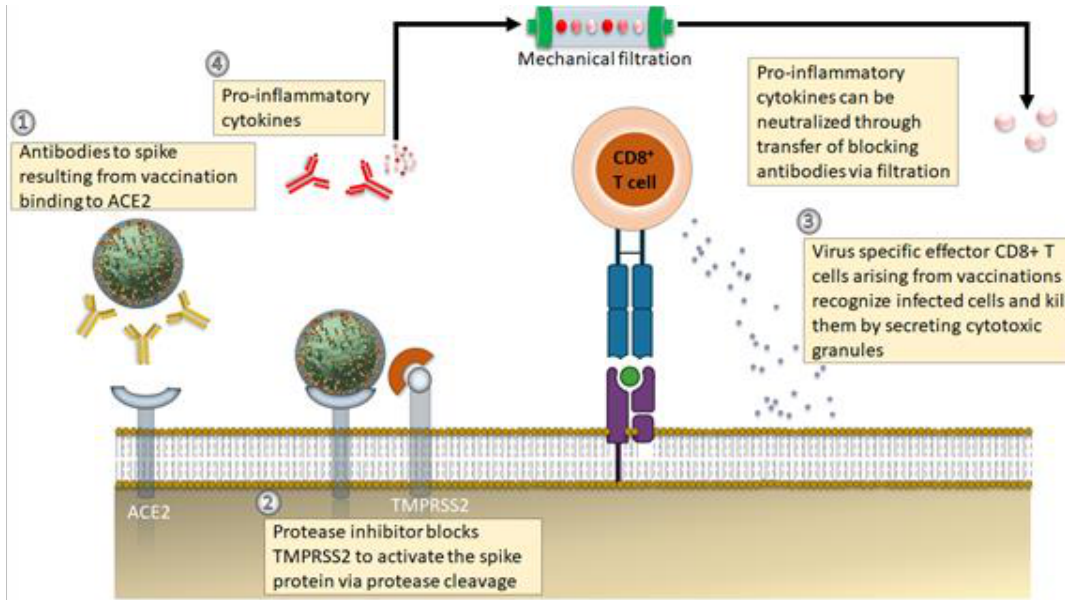
Figure 1. Emerging therapeutic approaches against COVID-19 disease. ( 1 ) Antibody-based thera- peutics against the S protein (either via adoptive transfer of vaccination) to avoid progression of severe infections. ( 2 ) Application of protease inhibitors against serine protease (TMPRSS2) prevents cleavage of S protein. ( 3 ) SRS-CoV-2 virus-specific memory CD8 + T cells from vaccination or earlier infection. ( 4 ) A new treatment approach targets the symptoms of cytokine storm, wherein the blood of infected patients is passed through customized filtration columns to capture pro-inflammatory cytokines before the pureblood returns to patients. Adapted and modified from